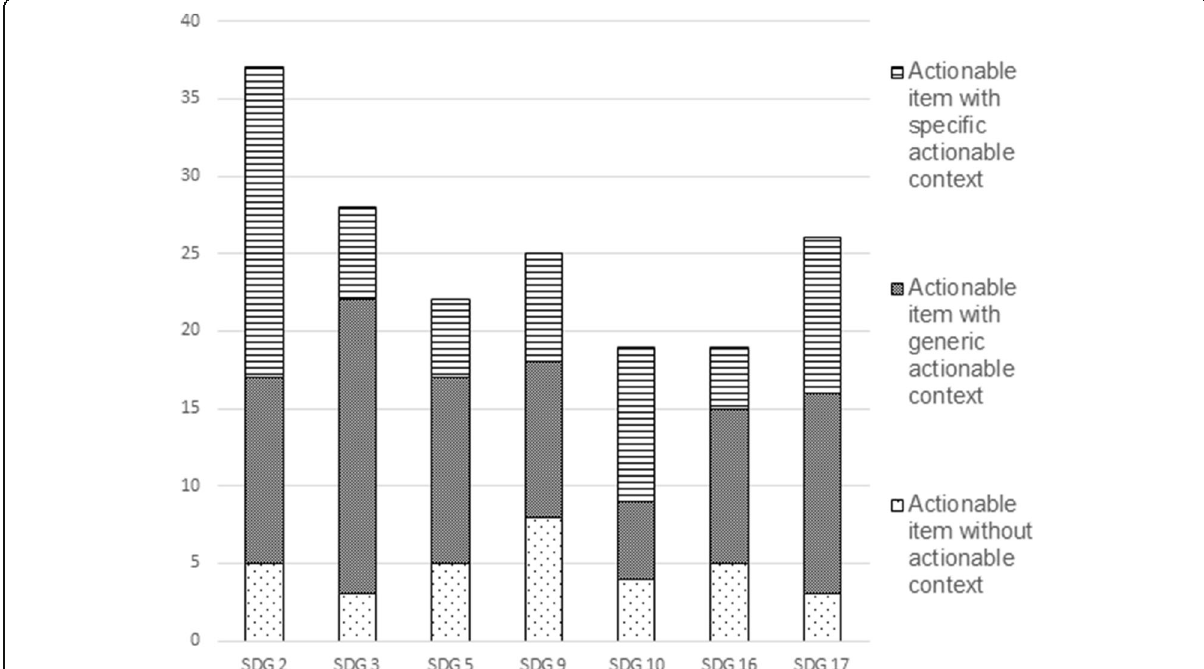
Fig. 8 Actionability disaggregated by tag. The graph indicates absolute numbers of items, not weighted in terms of individual SDG word count. As there were no instances of non-actionable items, this category is not included in the figure